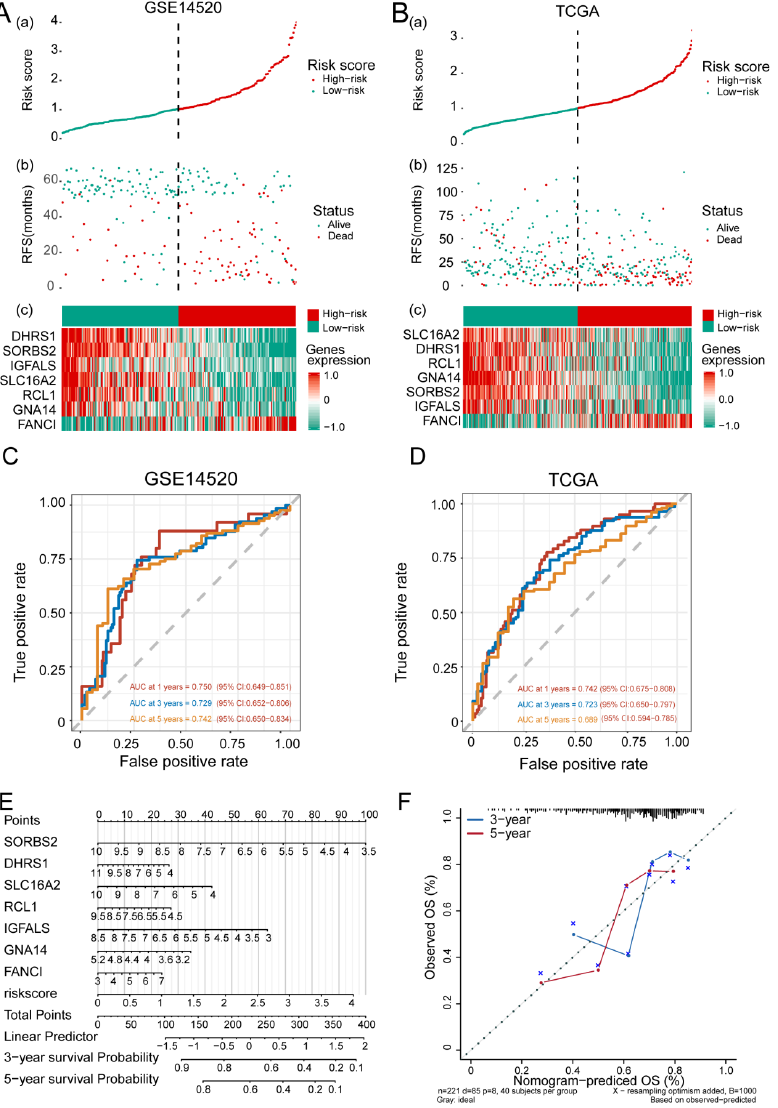
Figure 4. The feature gene-based risk score serves as a prognostic tool in hepatocellular carcinoma (HCC). ( A,B ) ( a ) Risk score, ( b ) survival status, and ( c ) expression of the seven feature genes in high-risk and low-risk HCC patients from the ( A ) GSE14520 and ( B ) TCGA datasets. ( C , D ) Time-dependent receiver operating characteristic curves of 1-, 3-, 5-year overall survival of patients in the ( C ) GSE14520 and ( D ) TCGA datasets. ( E ) Quantification of overall survival using nomograms. Lines are drawn upward to determine the points received from the predictor. The sum of these points is reported on the “Points” axis. A line is then drawn downward to determine the 3- and 5-year survival probability based on the seven feature genes. ( F ) Calibration plots showing the performance of nomograms with an ideal model for 3- and 5-year survival. RFS, recurrence-free survival; TCGA, The Cancer Genome